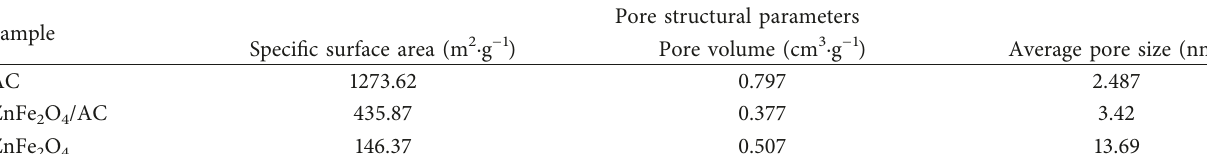
Table 2: Characteristics of activated carbon.